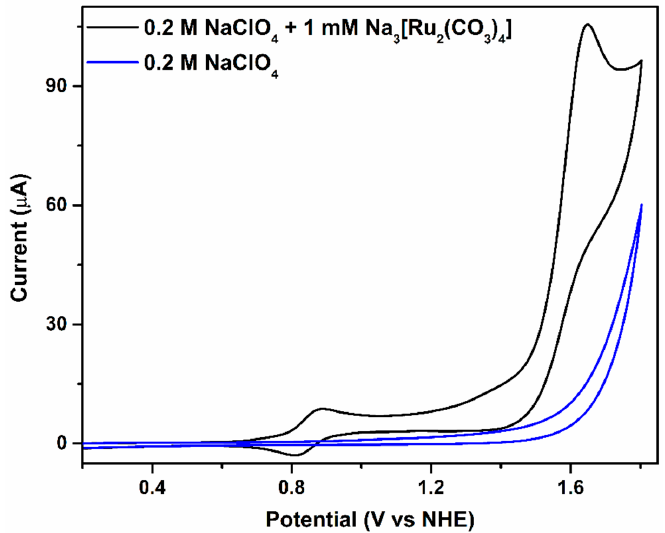
Figure 1. Cyclic voltammograms of a solution containing 0.20 M NaClO 4 (pH 7.0) in the presence and absence of 1.0 mM Na 3 [Ru 2 ( µ -CO 3 ) 4 ] at a scan rate of 50 mV·s − 1 under N 2 atmosphere.